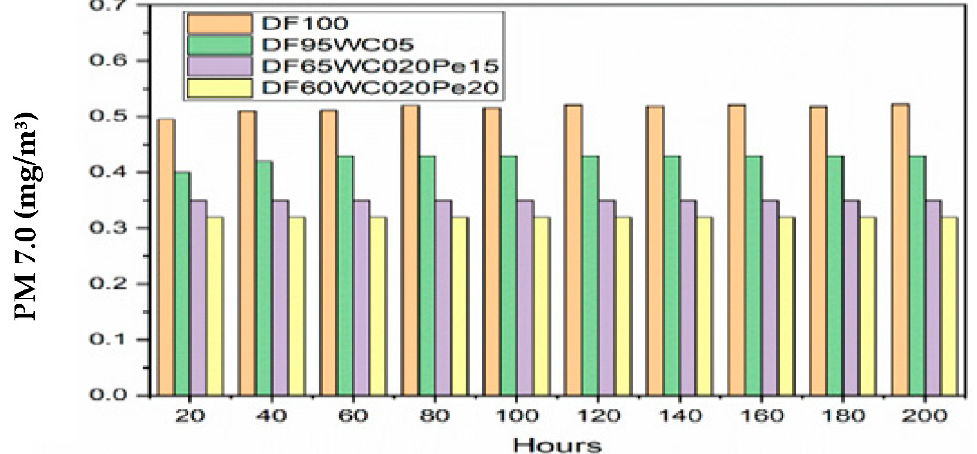
Figure 9. Particulate emission 7.0 (ppm) versus engine running hours.